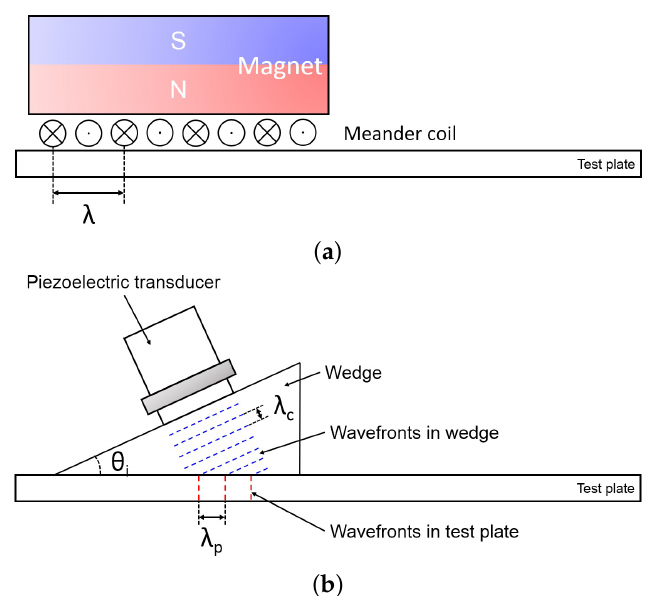
Figure A1. Representation of the excitation of guided waves through ( a ) an EMAT or ( b ) a piezoelec- tric transducer